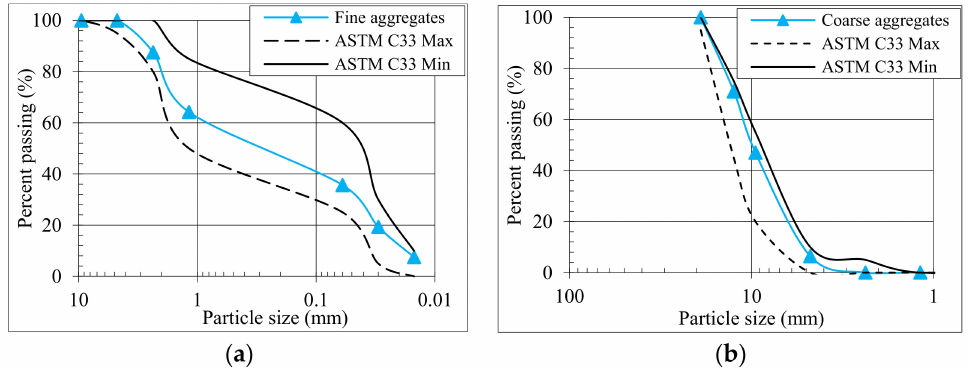
Figure 1. Granulometric analysis of ( a ) fine aggregates ( b ) recycled coarse aggregates.